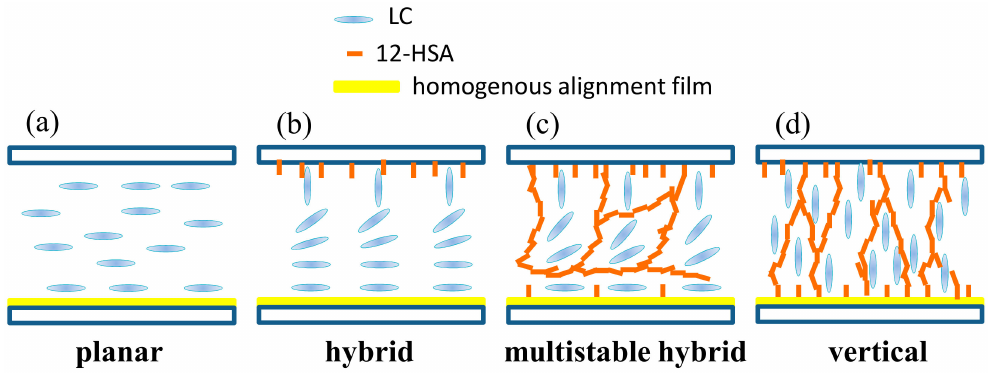
Figure 7. ( a ) Electro-optical curves; ( b ) phases; and ( c ) POM images of positive LCs (HFW59200-200) doped with various gelator concentrations.